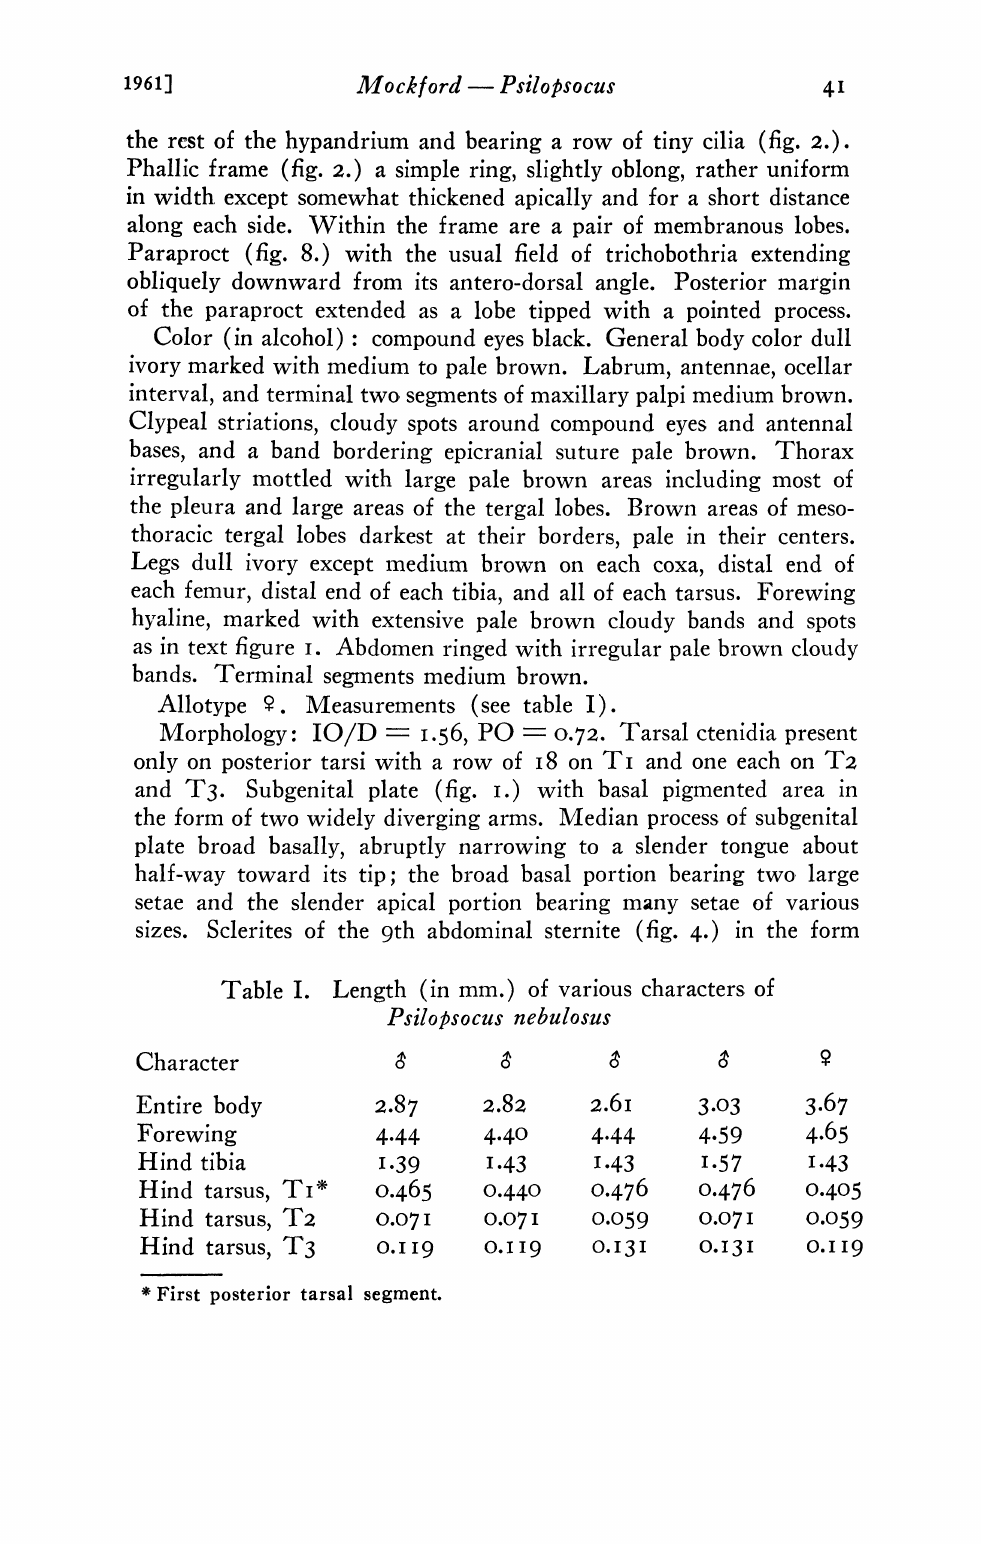
Table I. Length (in ram.)